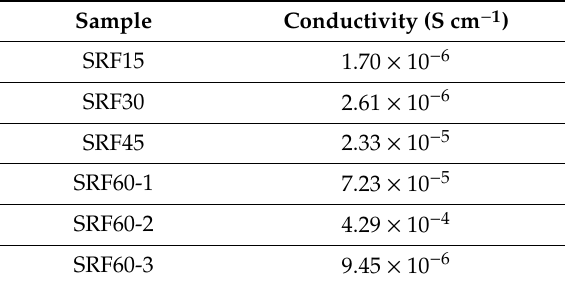
Table 2. Conductivity values for respective polymer